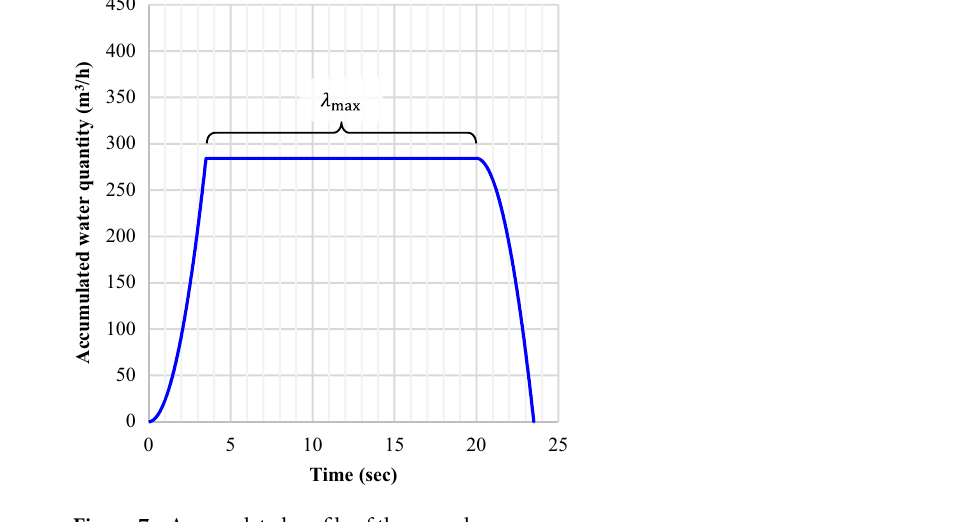
Figure 7. Accumulated profile of the quench.